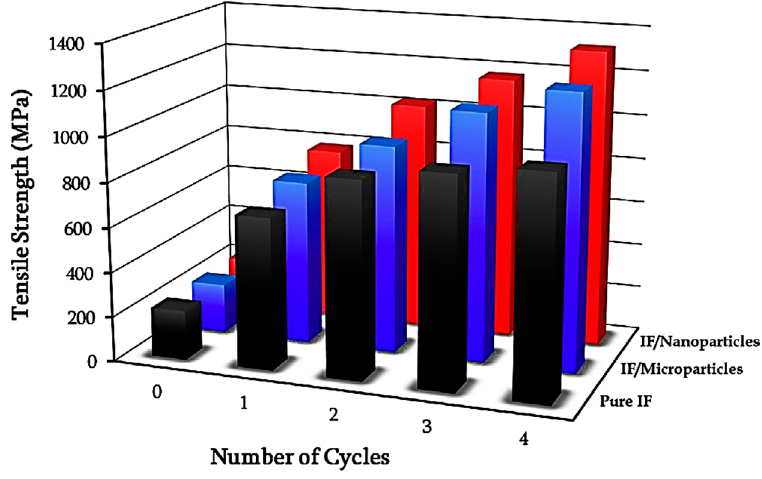
Figure 10. Tensile strength of ARBed pure IF steel, composite and nanocomposite versus number of cycles [60].